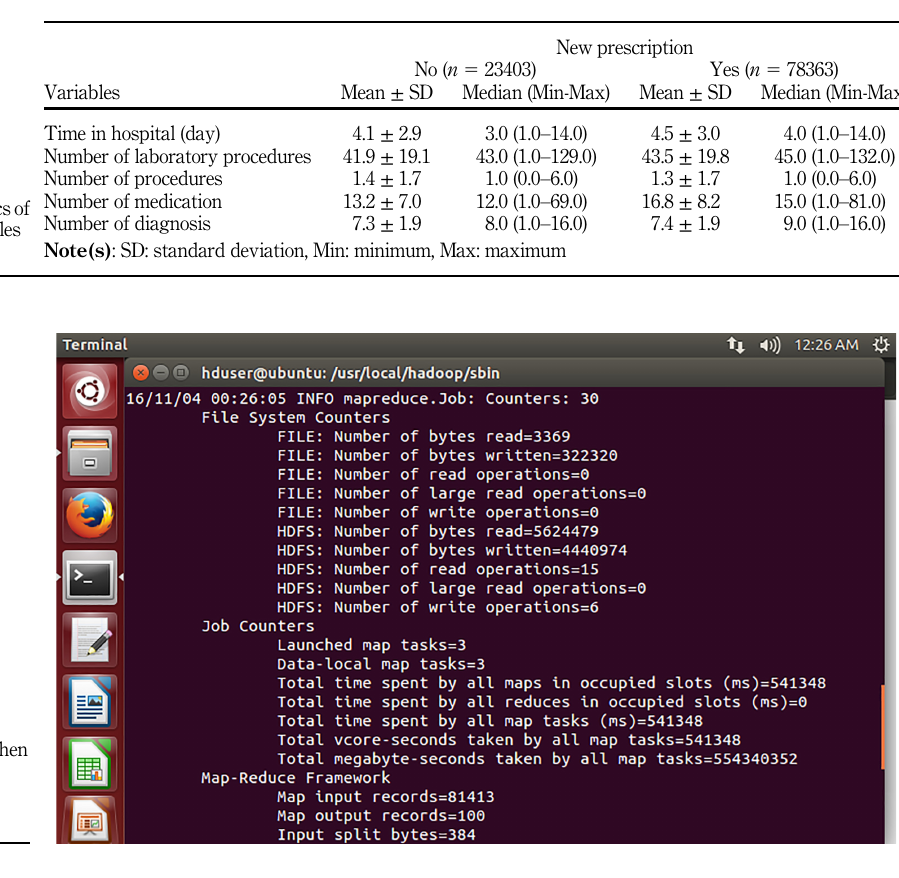
Figure 1. Read, write, byte amounts and processing times when creating Mahout random forest training